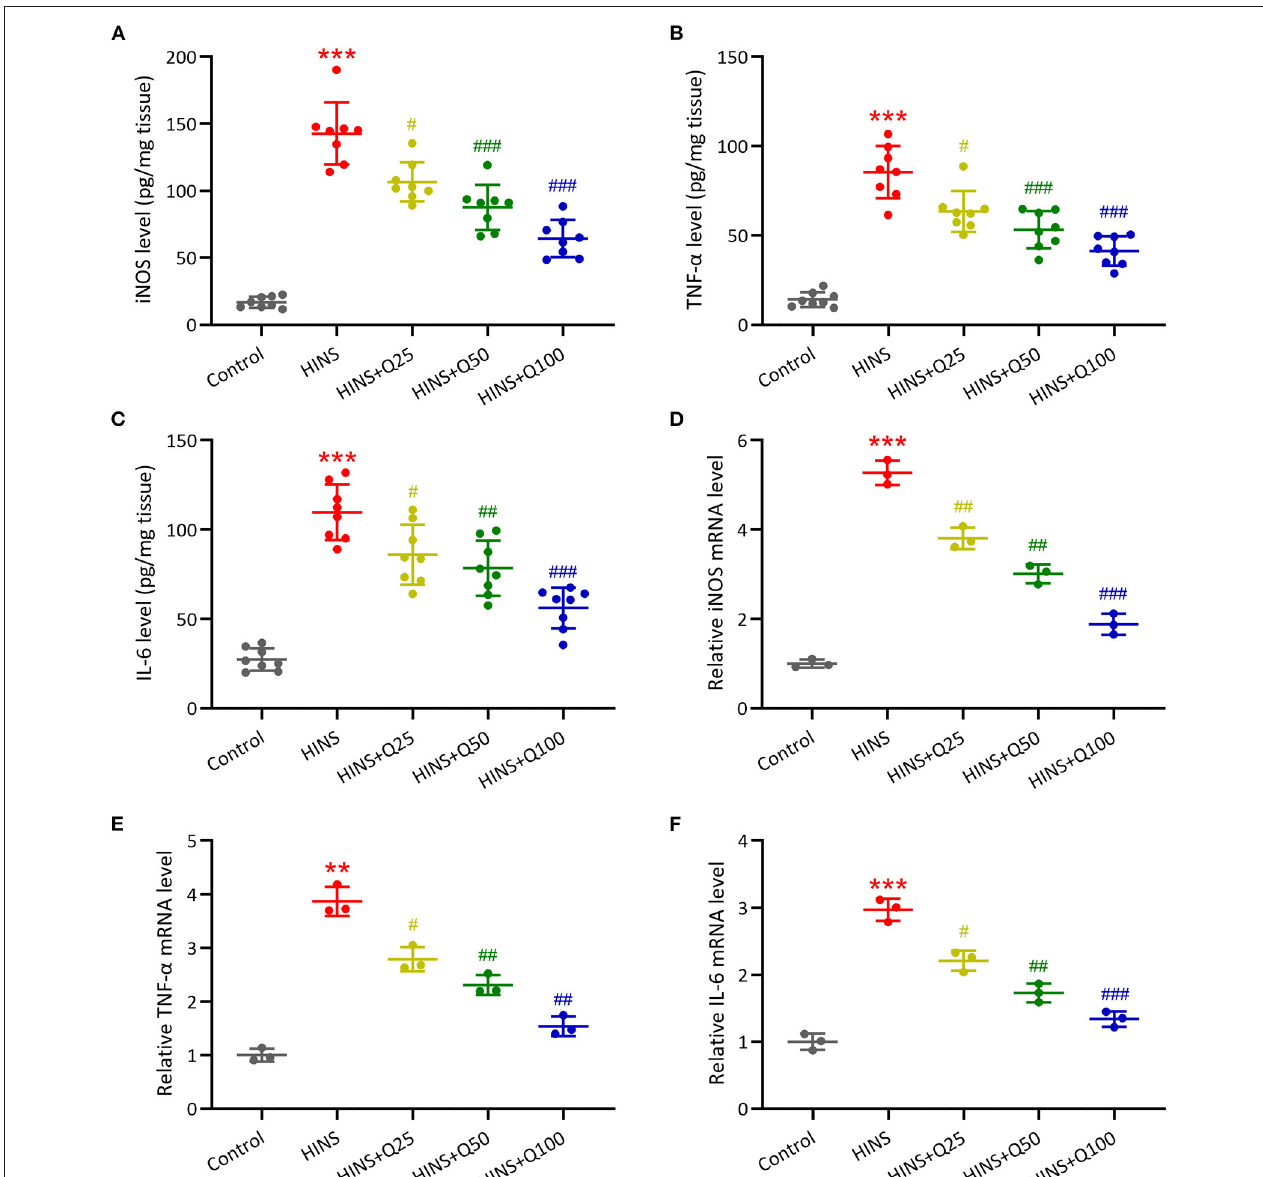
FIGURE 5 | Quercetin administration following HINS attenuated hippocampal inflammatory responses of rats. ELISA was used to measure the concentrations of iNOS (A) , TNF- α (B) , and IL-6 (C) in the hippocampus of rats from different groups. RT-qPCR was used to measure the mRNA expressions of iNOS (D) , TNF- α (E) , and IL-6 (F) in the hippocampus of rats from different groups. Eight or 3 rats were used in each group. Mean ± SD. ** p < 0.01, *** p < 0.001 compared to control. # p < 0.05, ## p < 0.01, and ### p < 0.001 compared to